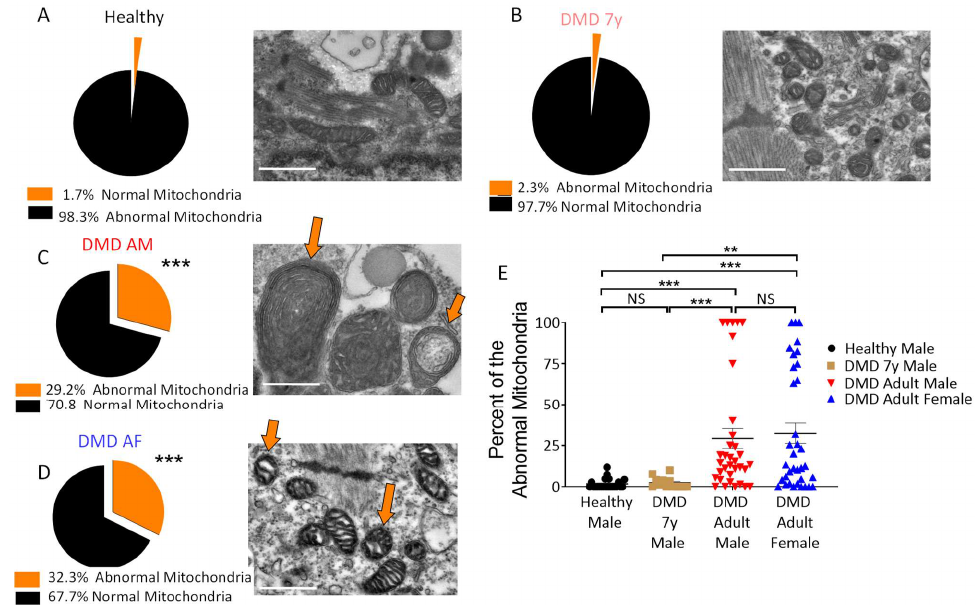
Figure 6. Morphological alterations in DMD mitochondria. Representative transmission electron microscopy (TEM) and analysis of healthy control ( A ), DMD 7-year-old (7y) ( B ), DMD adult male (AM) ( C ) and DMD adult female (AF) ( D ) CMs. The mitochondria abnormalities in DMD adult male and female CMs included increased size, reduced matrix density and disrupted cristae (orange arrows). ( E ) A summary of the abnormal mitochondria in the four experimental groups. The extent of abnormal mitochondria was calculated as the percentage of abnormal mitochondria among the total individual mitochondria (normal + abnormal mitochondria). The summary shows a significant increase in abnormal mitochondria percentage in DMD adult male and female CMs compared to DMD 7y and healthy control CMs. Normal mitochondria: healthy, n = 584; DMD 7y, n = 543; DMD adult male, n = 1063; DMD adult female, n = 1599. Abnormal mitochondria: healthy, n = 11; DMD 7y, n = 11; DMD adult male, n = 296; DMD adult female, n = 556. Welch’s ANOVA test (for non- parametric distribution) was used for statistical comparisons. ** p < 0.01, *** p < 0.001, NS = not significant. Scale bar 500 nm.